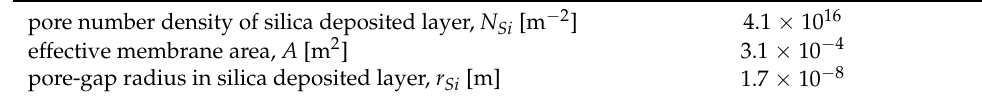
Table 1. Properties of silica-deposited